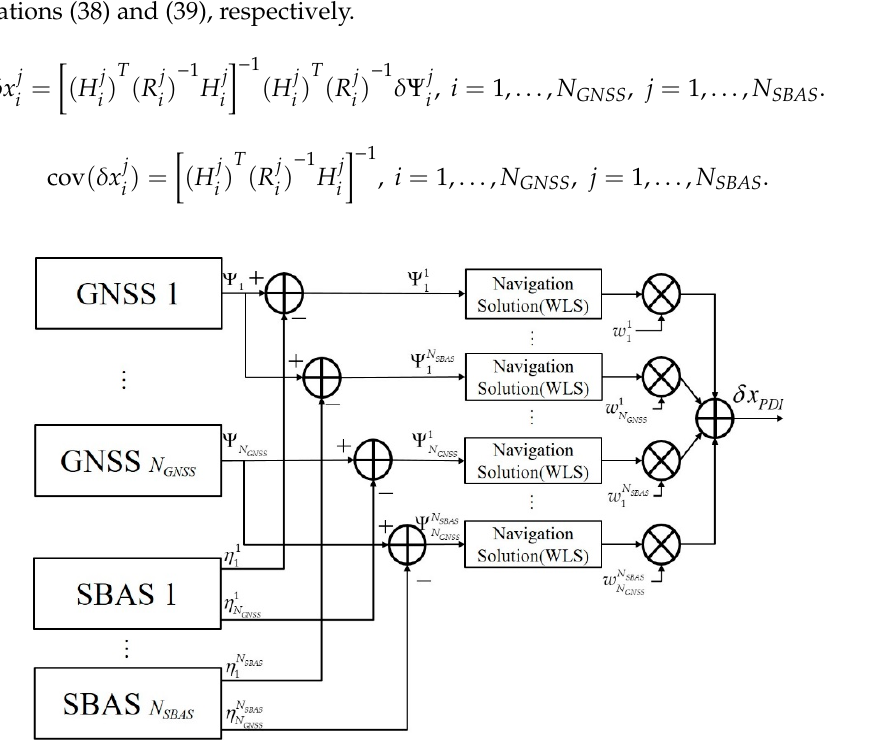
Figure 7. PDI for multi-GNSS augmented with multi-SBAS.